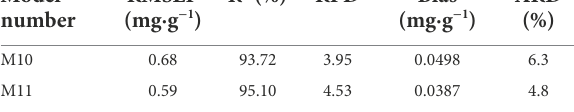
TABLE 4 Statistic results of the test set. Model